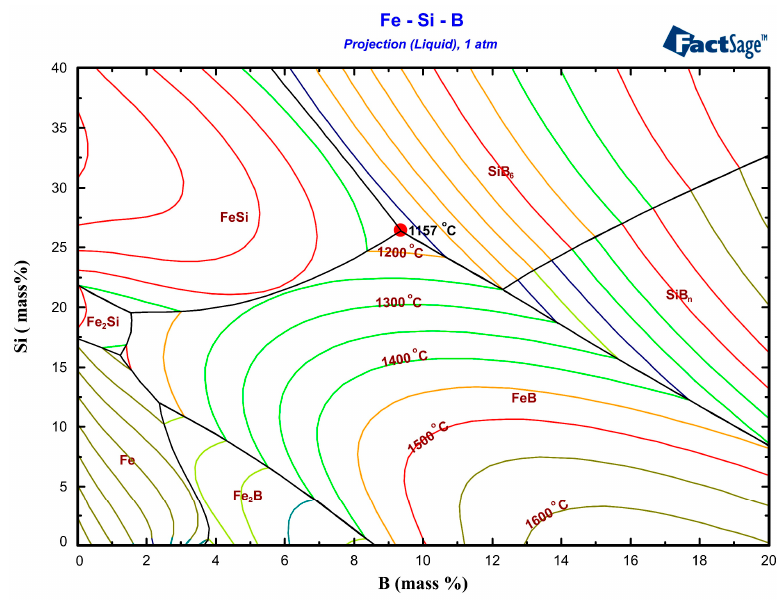
Figure 1. Projection of Fe-Si-B system, where red point represents the Fe-26.38Si-9.35B eutectic alloy (FTlite database).